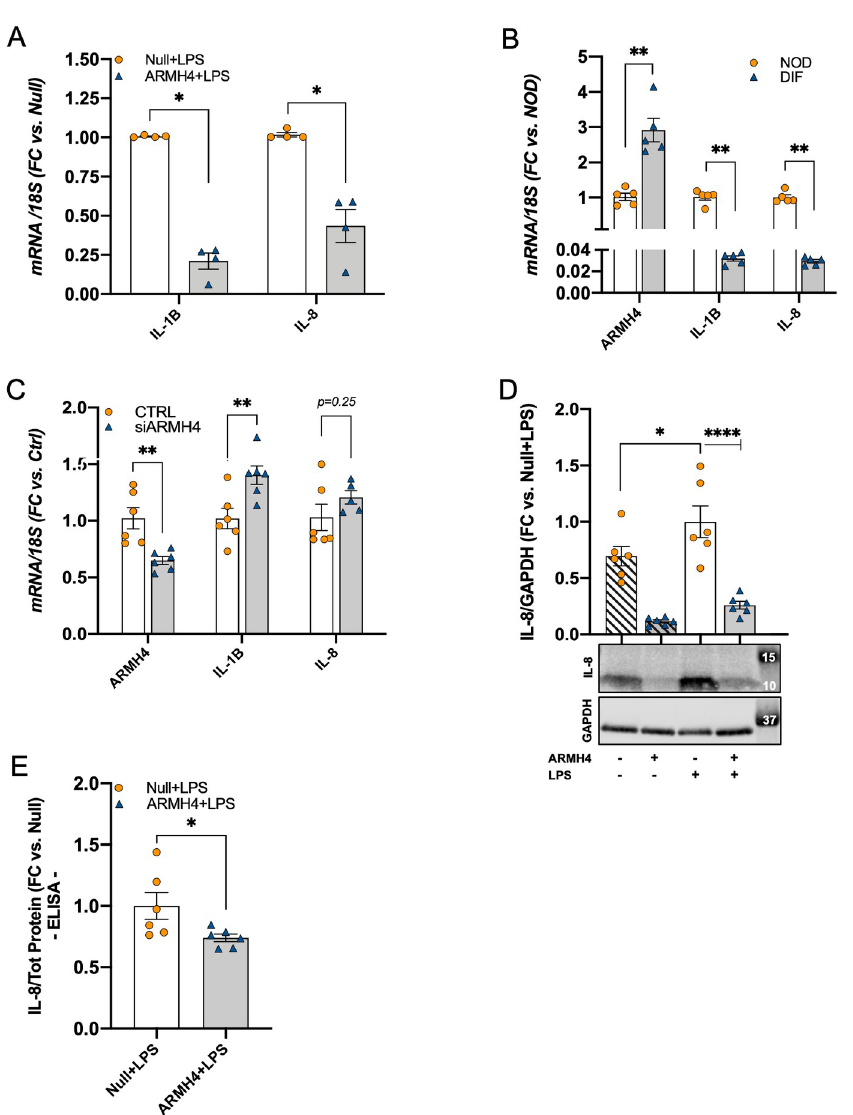
Fig 4. ARMH4 may protect podocytes from inflammatory insults. A : viral overexpression of ARMH4 reduces IL-1B and IL-8 mRNA levels in hPTCs stimulated with LPS. B : the levels of both IL-1B and IL-8 are reduced in differentiated podocytes in parallel with the spontaneous increases of ARMH4. C : silencing ARMH4 results in the upregulation of IL-1B . The anti-inflammatory effect of ARMH4 was confirmed for IL-8 at the protein level using Western blotting ( D ) and using ELISA ( E ). For these two latter experiments, samples are from two patients with three replicates from each ( n = 6). Total protein concentration in cell lysates was used to normalize protein levels in supernatants.